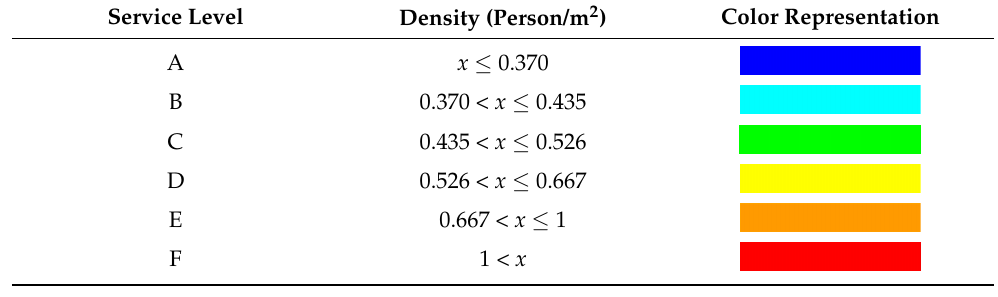
Table 4. IATA Waiting Level Table.